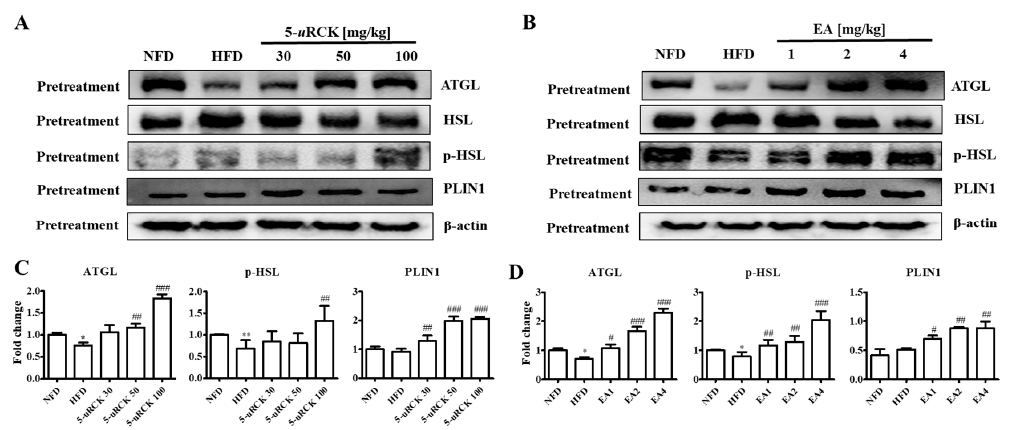
Figure 12. E ff ect of 5- u RCK and ellagic acid supplementation on lipolysis-associated protein in HFD-fed mouse visceral epididymal white adipose tissue (eWAT). E ff ects of 5- u RCK ( A ) and ellagic acid ( B ) on ATGL, HSL, p-HSL, and PLIN1 expression in eWAT and assessed by Western blot analysis. Each value ( C , D ) was normalized to β -actin and expressed as the mean ± SD. The levels of p-HSL (Ser563) proteins were normalized to HSL and expressed as the mean ± SD. P values for comparisons with control groups (NFD groups) are denoted as * p < 0.05 and ** p < 0.01, and those for comparisons with HFD groups are denoted as # p < 0.05, ## p < 0.01, and ### p < 0.001.